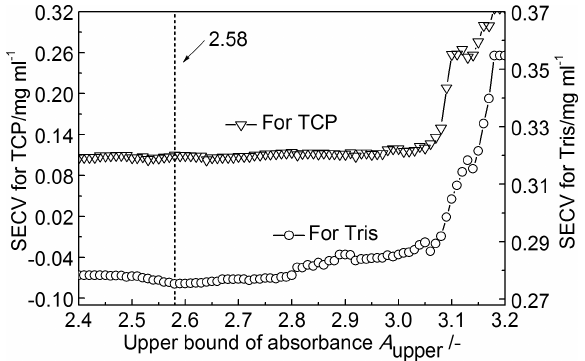
Fig. 7. SECV values for each upper bound of absorbance A – PLS method for TCP and upper with the AO